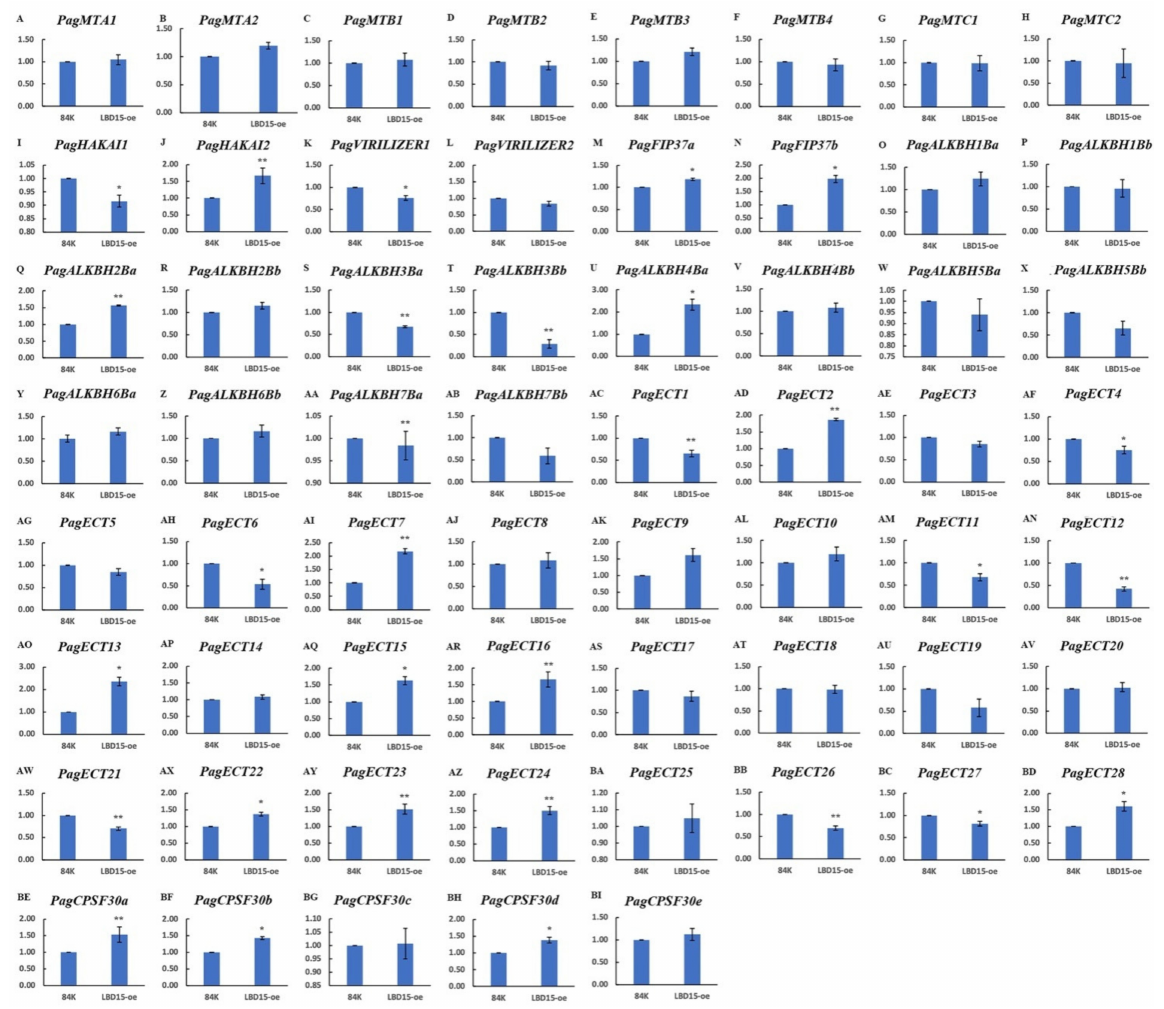
Figure 6. qPCR validation of 61 m 6 A pathway genes in Poplar 84K and LBD15-oe plants. Figure ( A )–( BI ) showed the expression level of 61 genes in Poplar 84K and LBD15-oe plants. A t -test was calculated using IBM SPSS 19 software. * represent p < 0.05 and ** represent p <